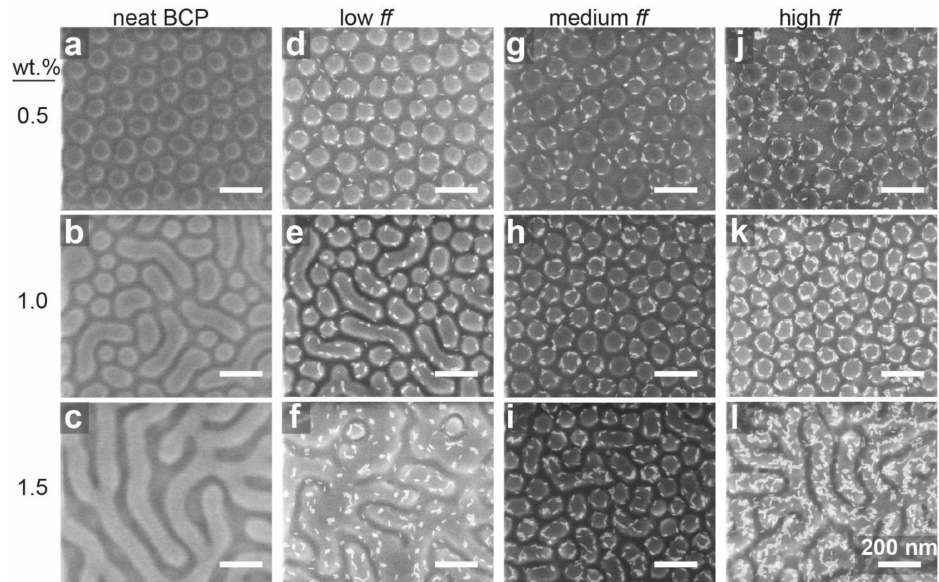
Figure 3. Effect of BCP concentration in nanocomposite films featuring different QR surface fractions and annealed in toluene. QR surface fractions were 0, 0.04, 0.08, and 0.13 for neat BCP ( a – c ), low